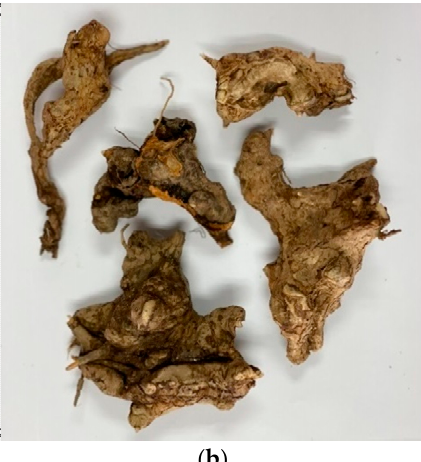
Table 7. Minimum inhibitory concentration (MIC) and minimum bactericidal concentration (MBC) .